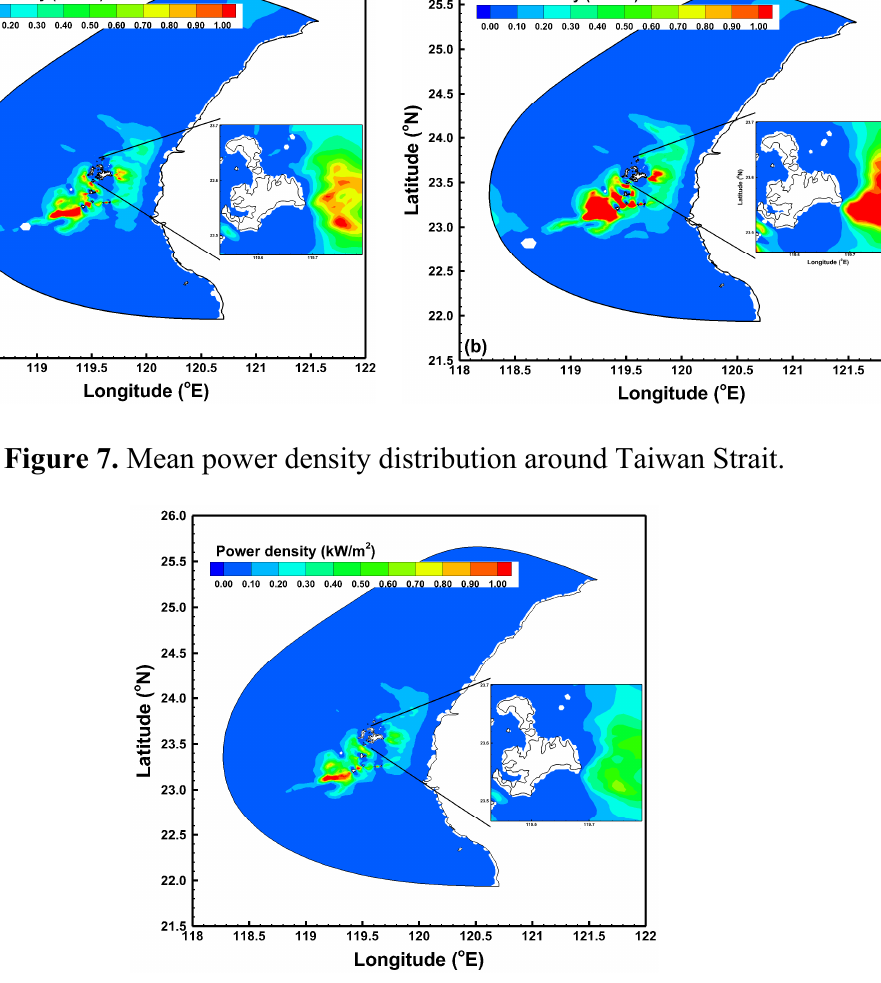
Figure 8. Simulated time distribution of tidal speed and power density with one turbine at the location of the turbine array over a spring-neap